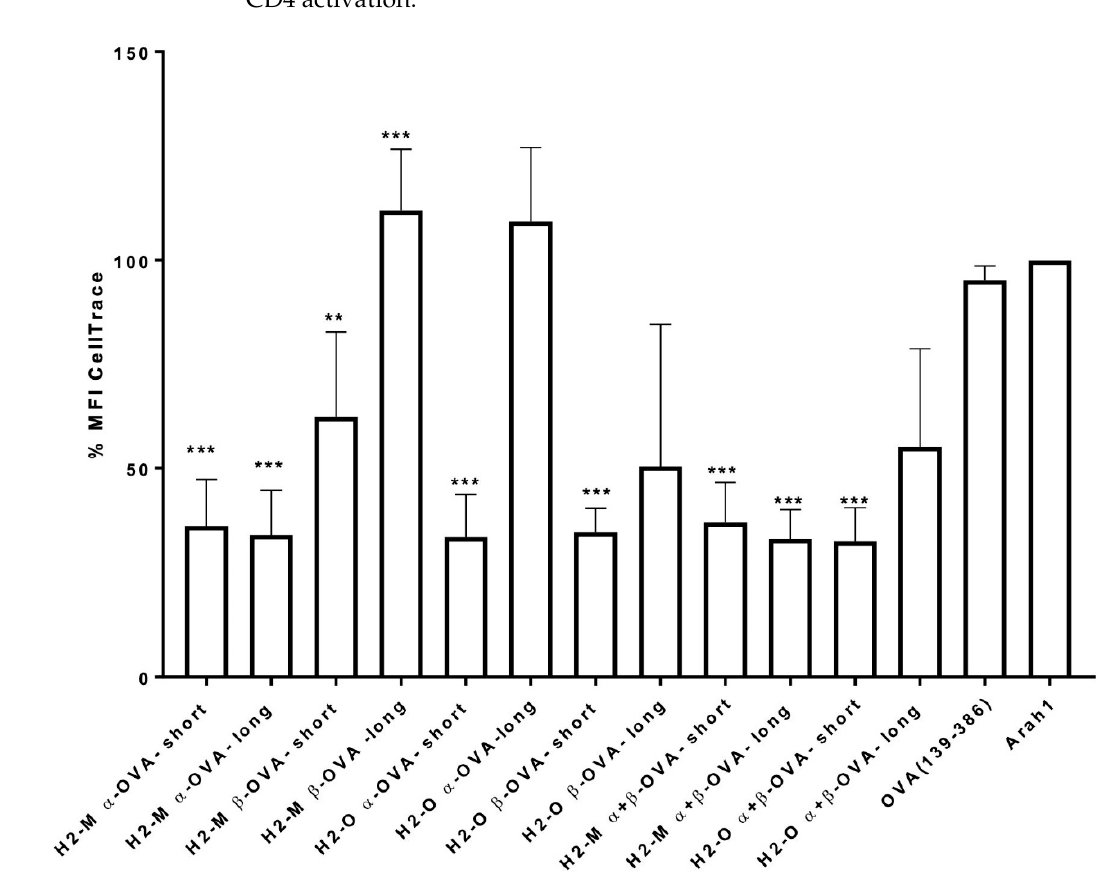
Figure 2. Improved CD4+ T cell activation in vitro mediated by H2-M and H2-O sequences. Fusion of OVA to H2-M or H2-O results in increased OVA-specific CD4+ T cell proliferation in comparison with unrelated mRNA (Arah) or non-fusion mRNA (OVA136-386). To assess the proliferation, murine OVA-specific CD4+ T cells were co-incubated for 3 days together with BM-DCs transfected with OVA-mRNA. The graph shows results from three independent experiments. Data shown are MFI (median fluorescence intensity) values of the cell membrane dye CellTrace normalized to the signal of the negative control Arah1. Statistics performed using one-way ANOVA. Control column Arah1. *** p < 0.001, ** p < 0.002.